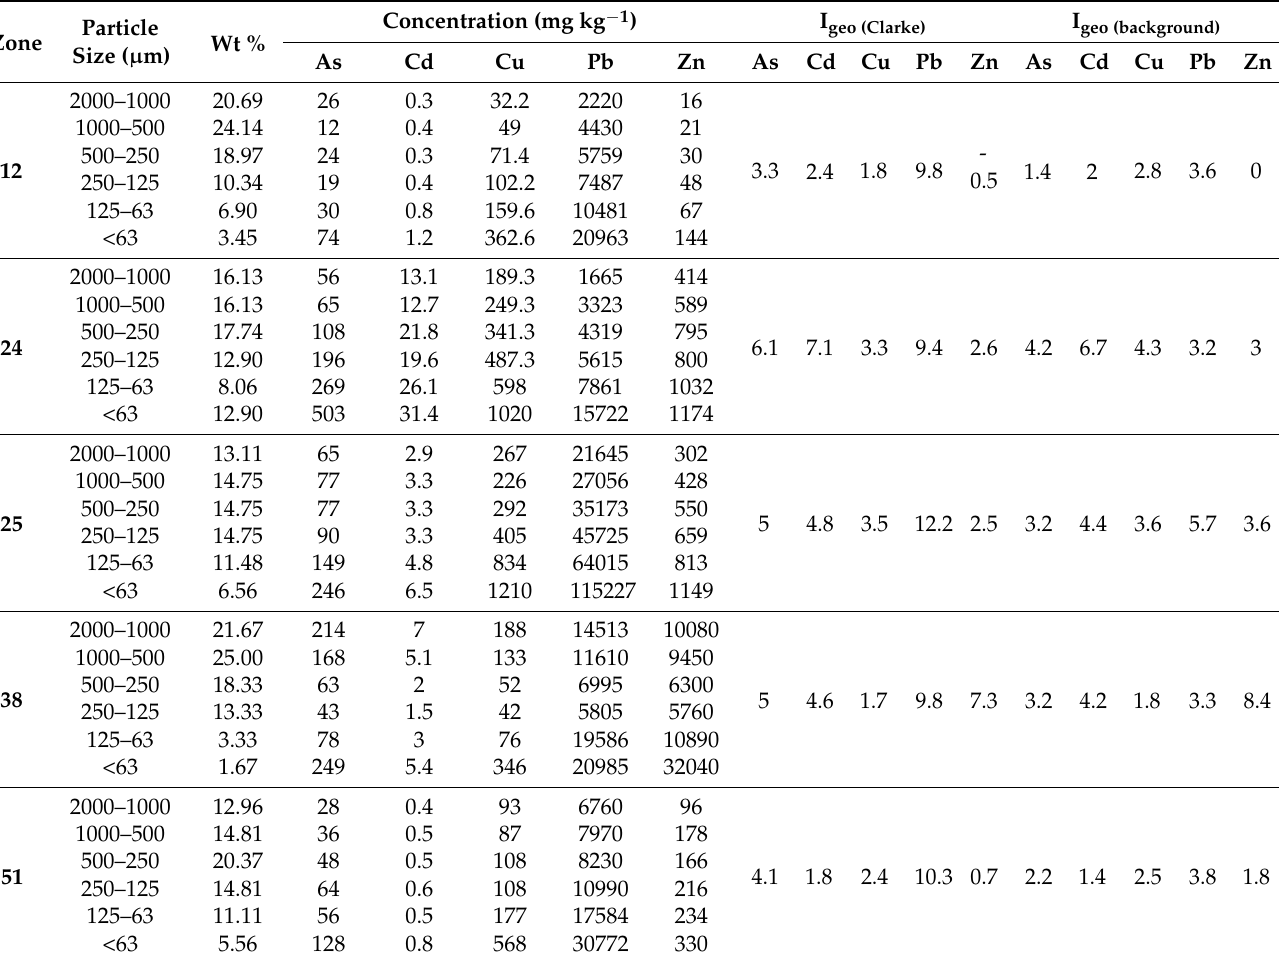
Table 3. Particle-size distribution, element concentration in each fraction, and Igeo for each study site. Igeo was calculated according to the Clarke and the local